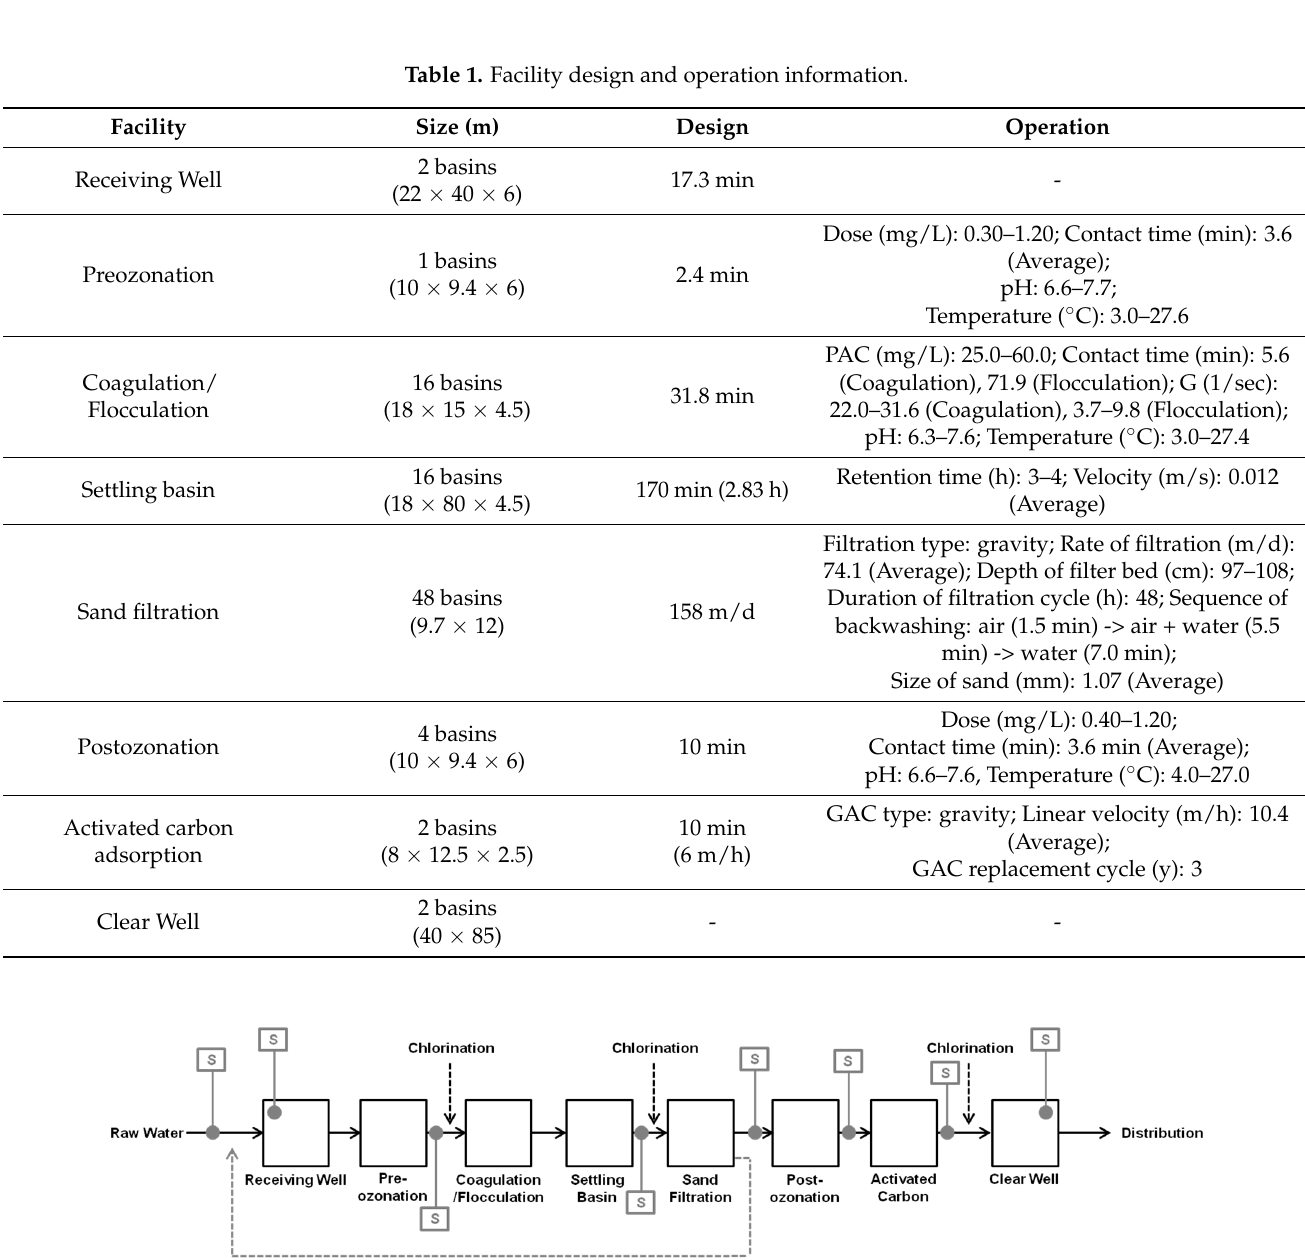
Figure 1. Schematic of the water treatment processes and sampling locations (S).